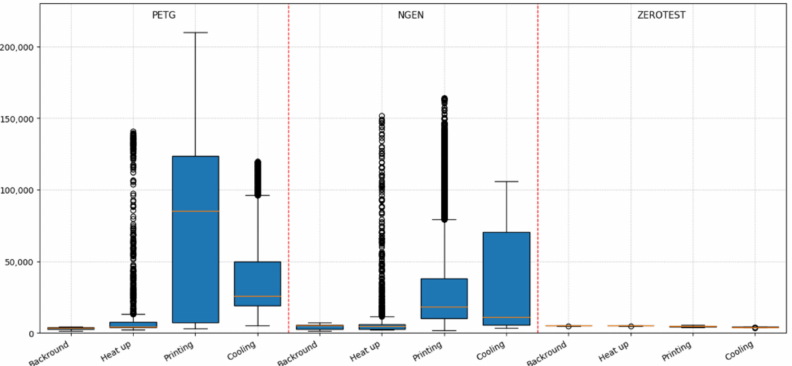
Figure 4. Particle number concentration emitted by polyethylene terephthalate (PETG) and styrene free co-polyester (NGEN) filaments and the zero